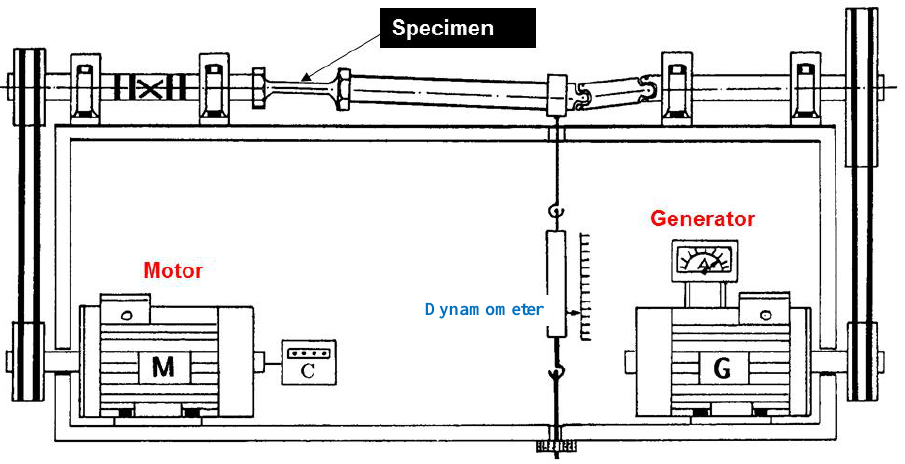
Figure 2: Schematic of testing machine for rotating bending with or without steady